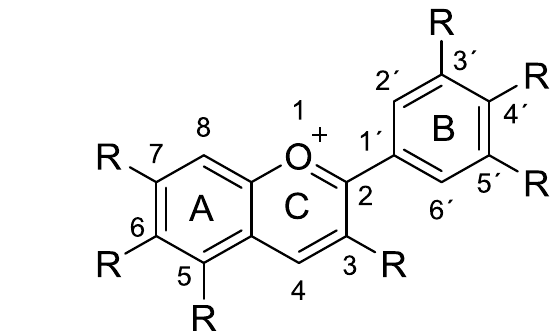
Figure 1. Chemical structure of the flavylium cation on the left and of anthocyanidin backbone on the right with atom numbering and ring label (R = H, OH).